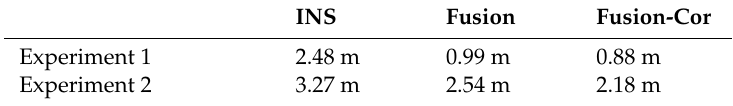
Table 3. Mean position error.